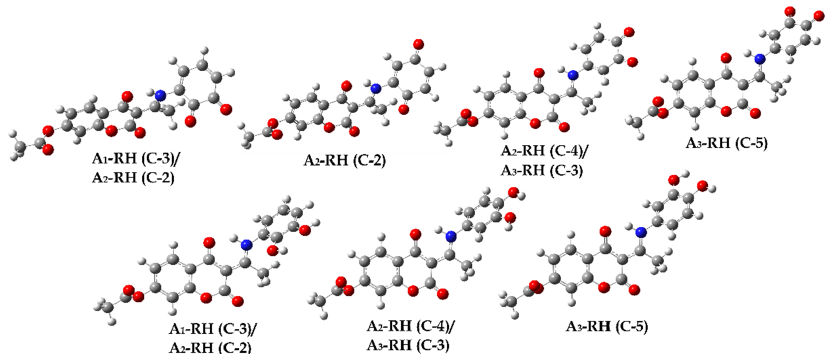
Figure 9. Optimized geometries of neutral final products P2 ( top ) and P4 ( bottom ) in water at M06 − 2X/6 − 311++G(d,p) level of theory.